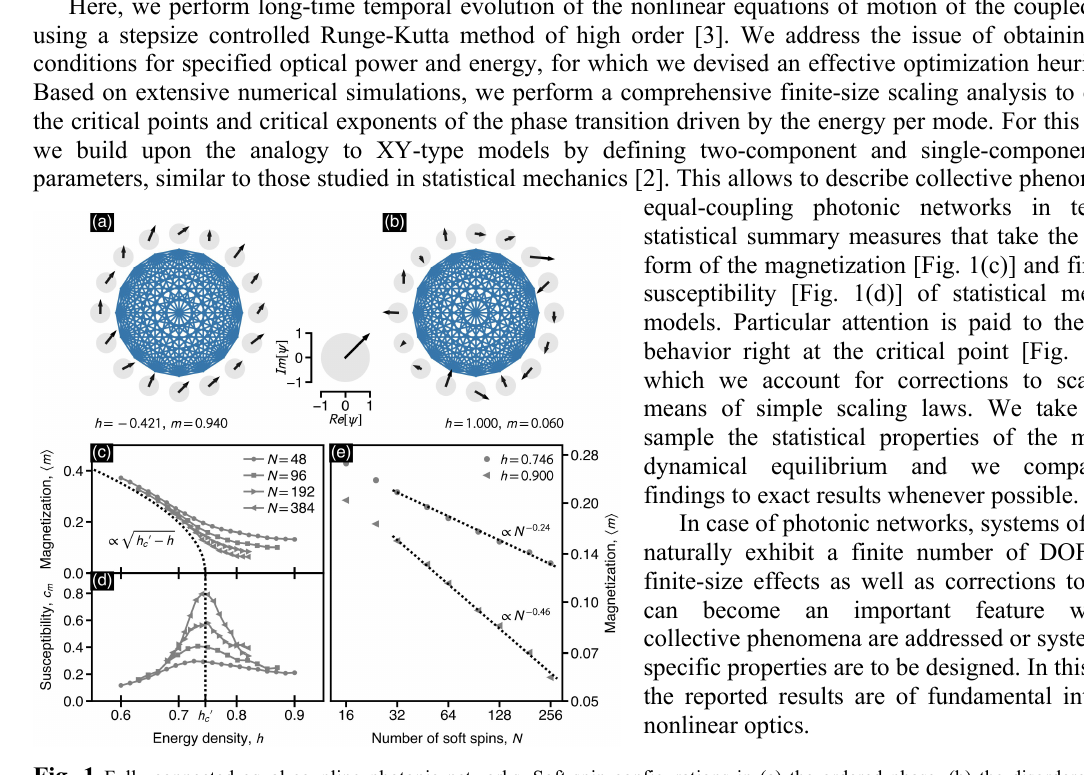
Fig. 1 Fully-connected equal-coupling photonic networks. Soft-spin configurations in (a) the ordered phase, (b) the disordered phase. (c) Scaling behaviour of the time-averaged magnetization, and, (d) scaling behaviour of the finite-size susceptibility as function of the energy per mode. (e) Finite-size scaling at fixed values of the energy per